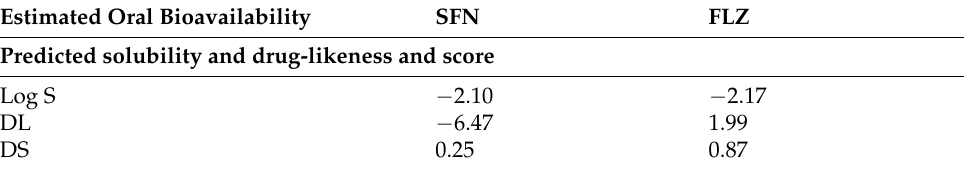
Table 2. Cont. Estimated Oral Bioavailability Predicted solubility and drug-likeness and score